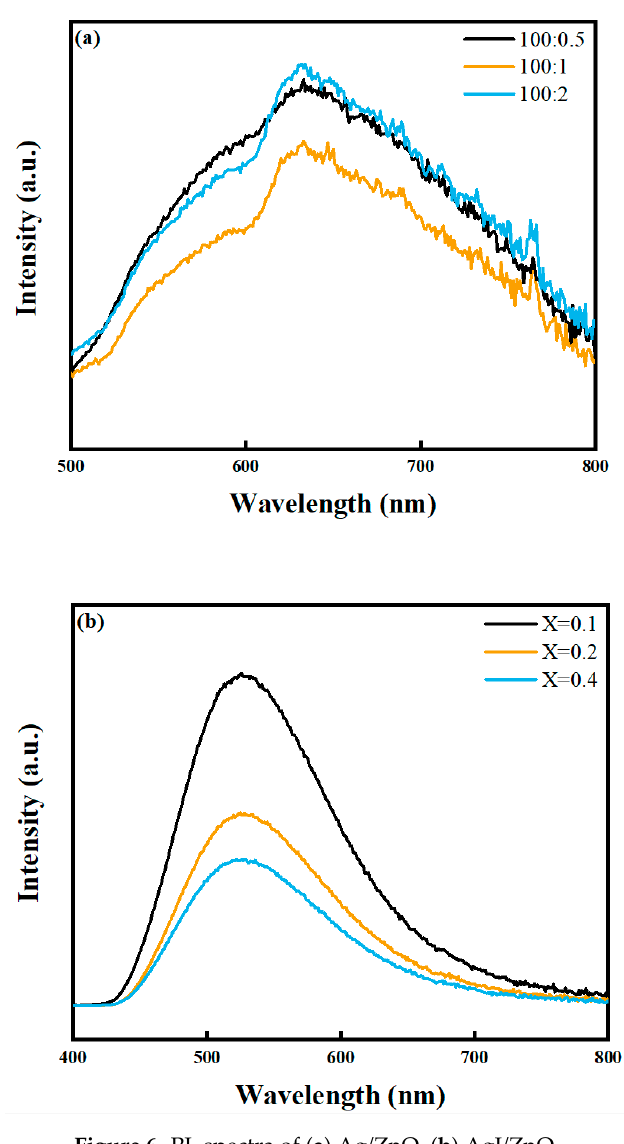
Figure 6. PL spectra of ( a ) Ag/ZnO, ( b ) AgI/ZnO.